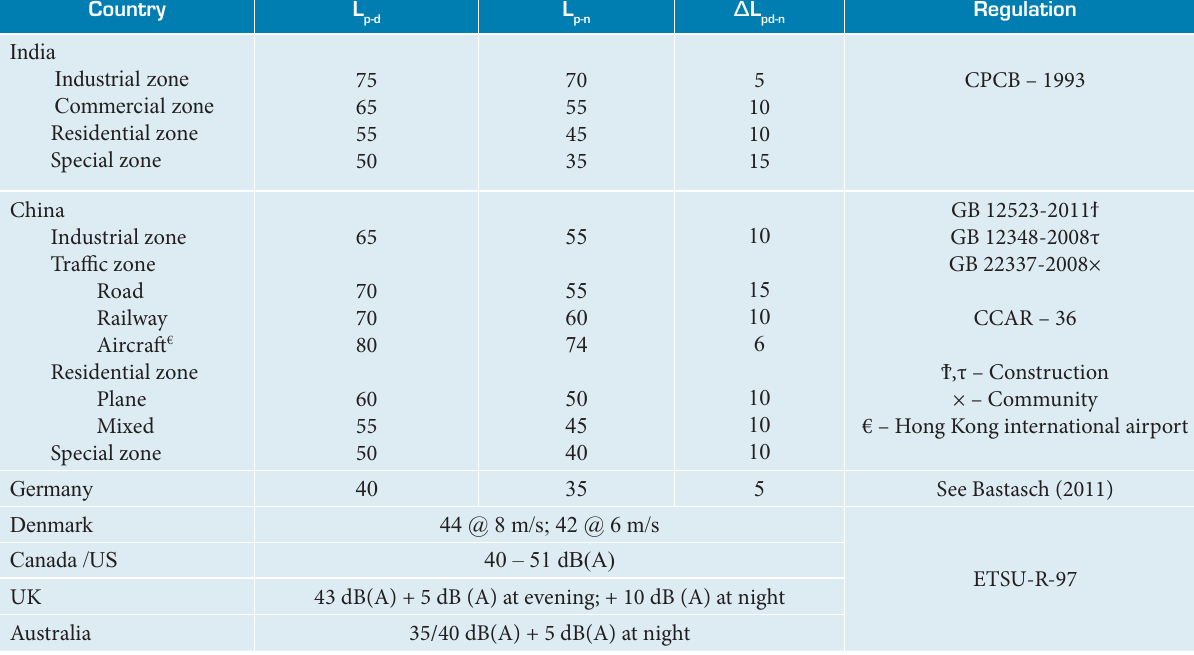
Table 1. General and wind turbine noise regulation standards, threshold limits in different countries. Country L